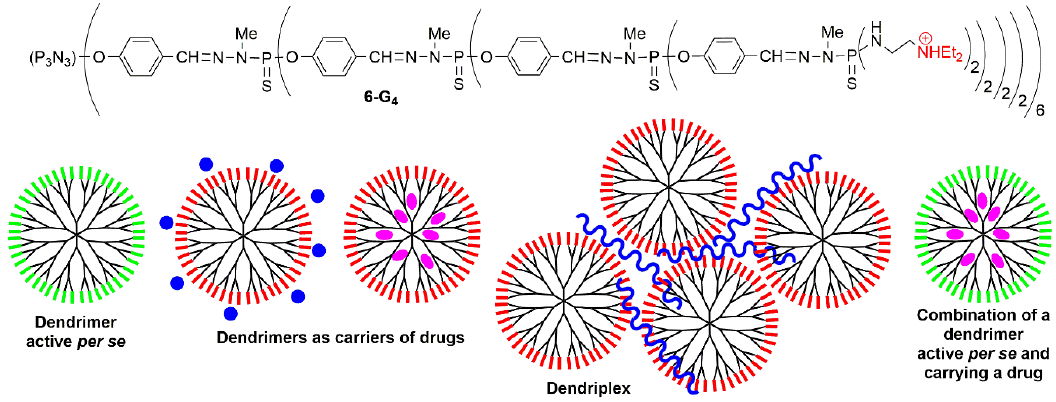
Figure 10. Positively charged dendrimer 6-G 4 , used as carrier.